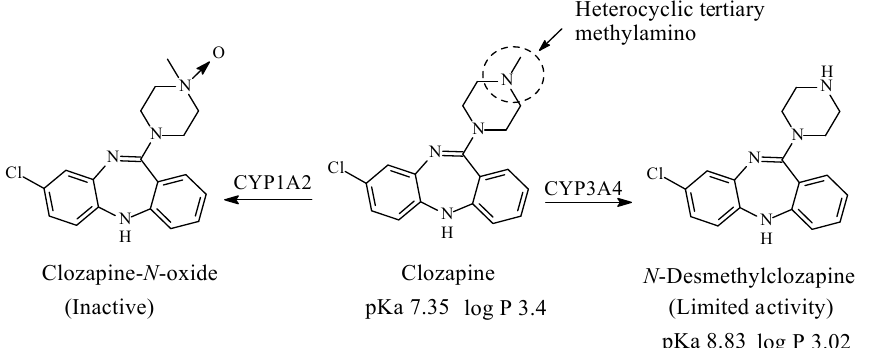
Figure 15. Metabolic pathways of clozapine.